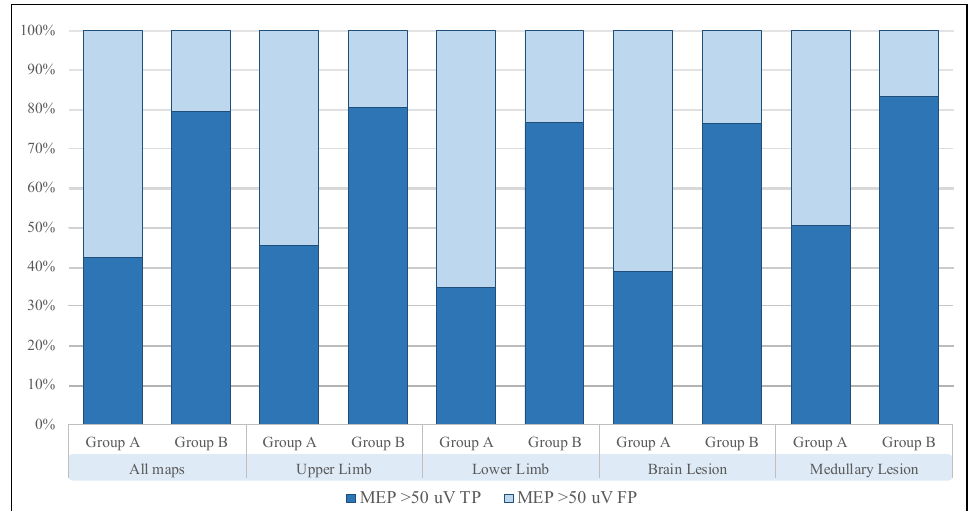
Figure 5. Schematic representation of true and false responses in the full sample and all subgroups. The trend is similar in all cases, and the analysis shows a steady increase in the ratio of true- to false-positive MEPs. (MEP, motor evoked potential; TP, true positive; FP, false positive).